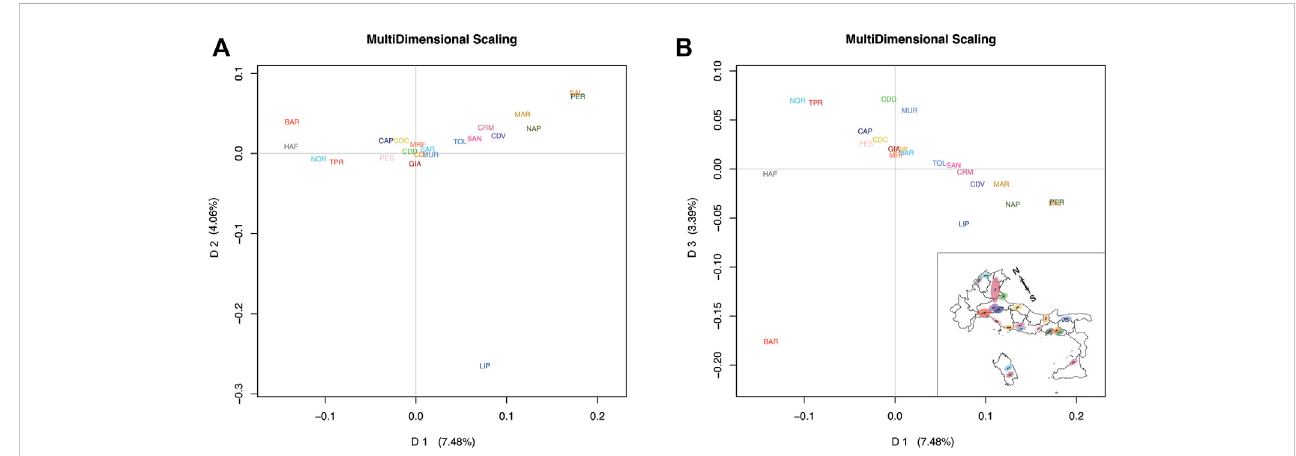
FIGURE 1 MDSplotsofaveragecoordinatesforeachbreedfortheItaliandataset.FulllistofusedacronymsisavailableinSupplementaryTableS1. (A) D1 vs .D2plot basedonItaliandatasetanalysis. (B) D1 vs .D3plotmirroringthegeographicItalianbreedsdistributioninthecountry.TheItalianmapgraphisrotatedforhigher clarity.